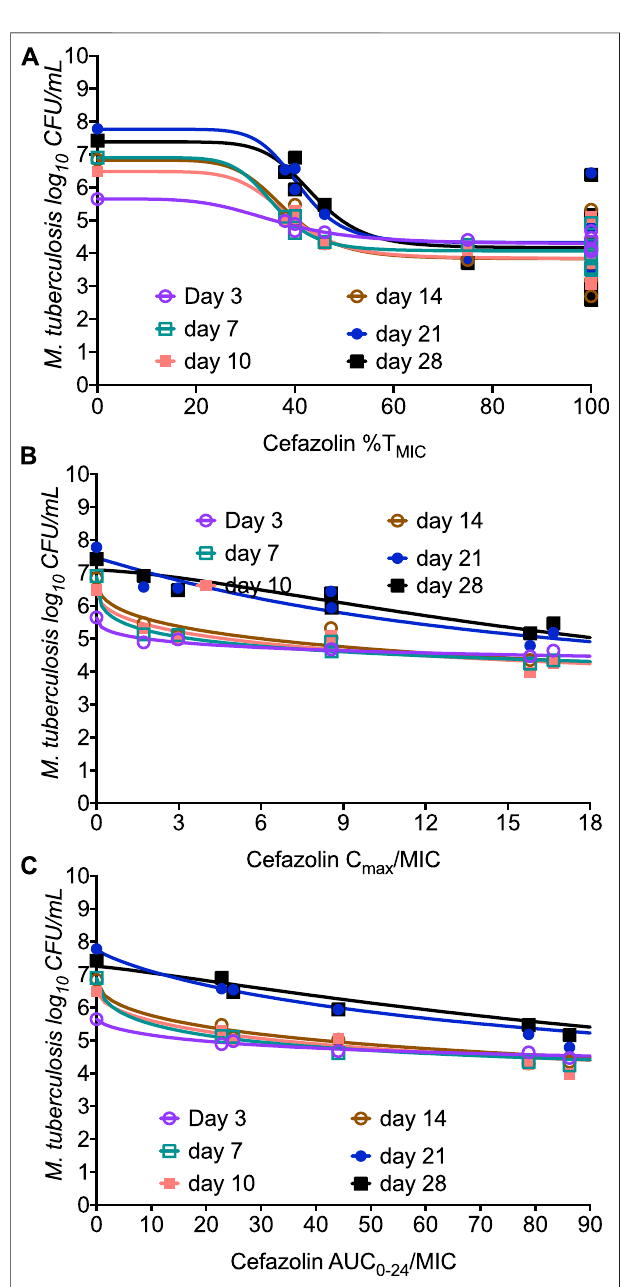
FIGURE4| Relationshipbetween Mtb burden andcefazolinexposurein the HFS-TB. The model fi t for each sampling day is shown in the fi gure for